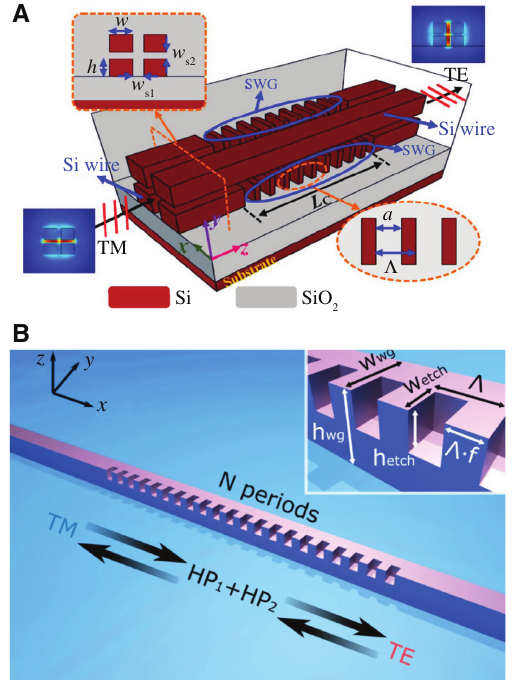
Figure 6: Schematic diagrams of the subwavelength structured